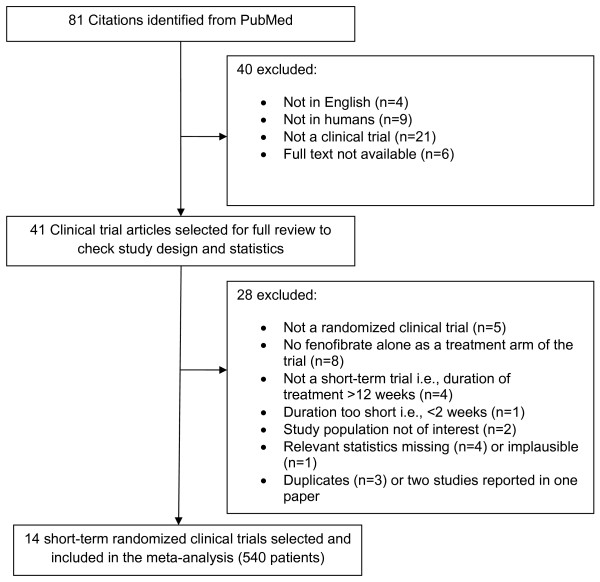
Flow chart showing how studies were selected for inclusion in the meta-analysis.